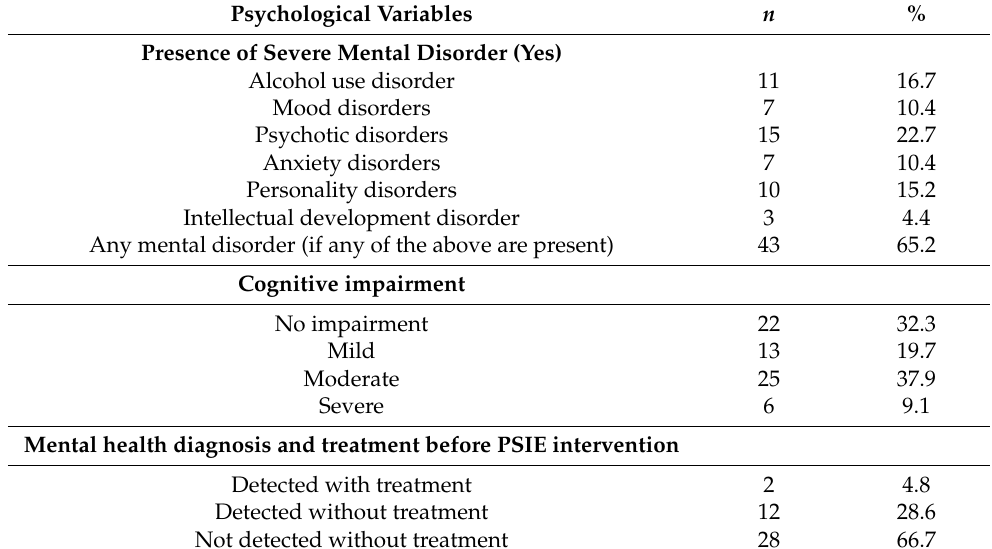
Table 2. Presence of symptomatology compatible with a severe mental disorder or cognitive impair- ment; mental health treatment; health and psychosocial functioning, global assessment of functioning, disability and socio-sanitary